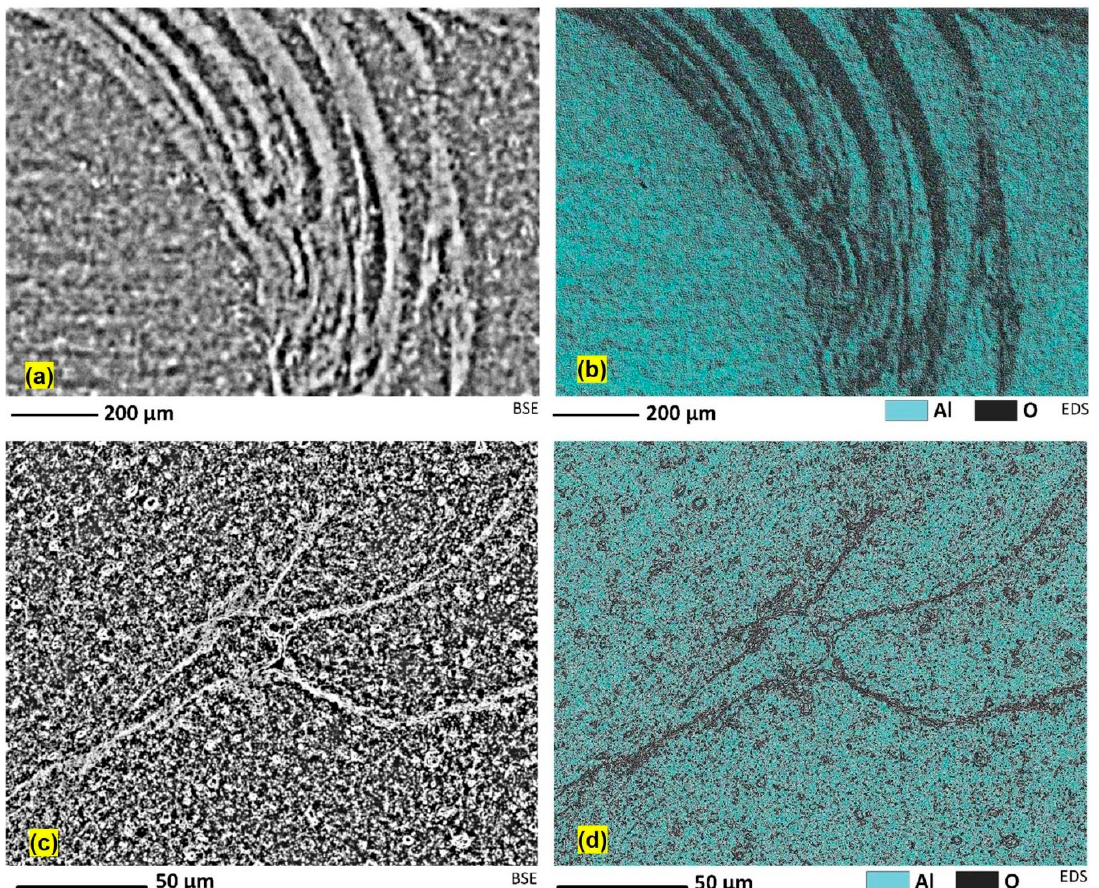
Figure 8. Analysis of the flow-arms region (region 1, Figure 4a) using ( a ) BSE, and ( b ) EDS elemental map, and similarly for ( c , d ) hair-line micro-crack position (demonstrated in Figure 7b). The oxygen-rich areas of the EDS elemental map have been delineated in dark ( b , d ).